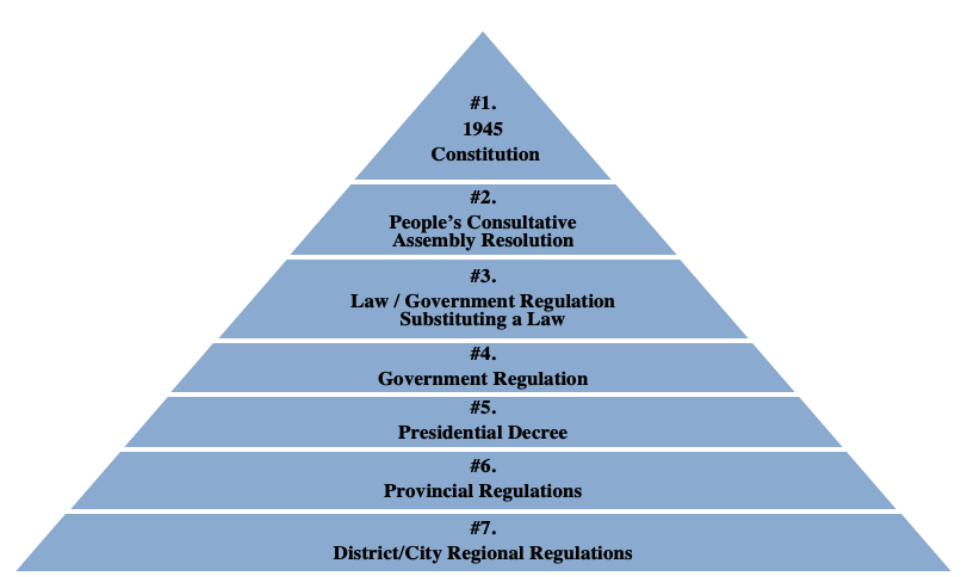
Figure 1: Hierarchy according to Law Number 12 of 2011 concerning the Establishment of Legislation Article 7 paragraph 1